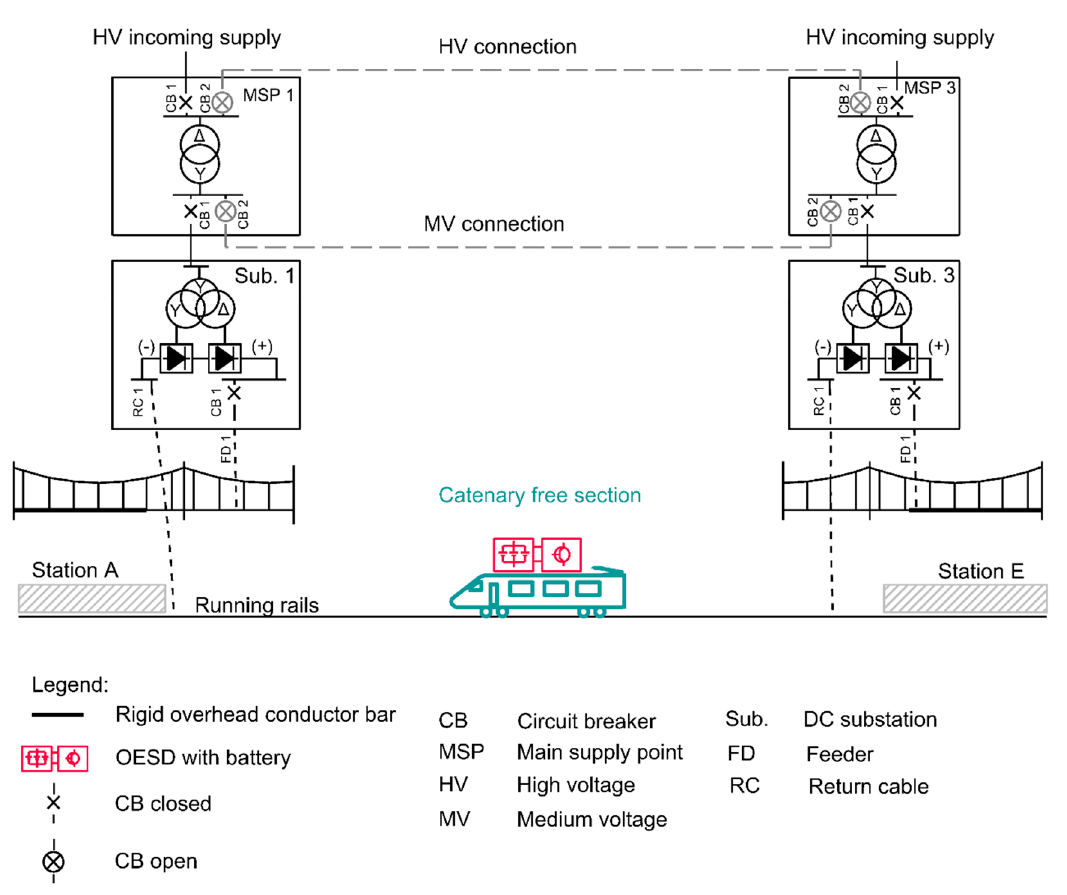
Figure 11. Catenary free section (tram fed from OESD with Li-Ion battery).